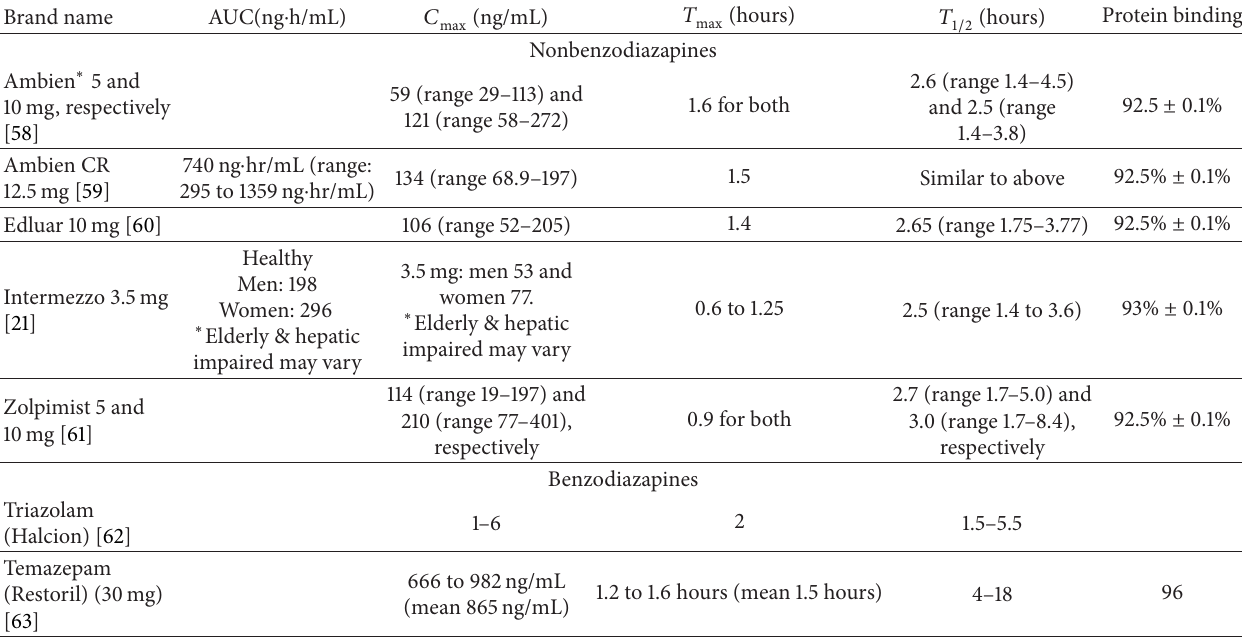
Table 2: Pharmacokinetic parameters for zolpidem